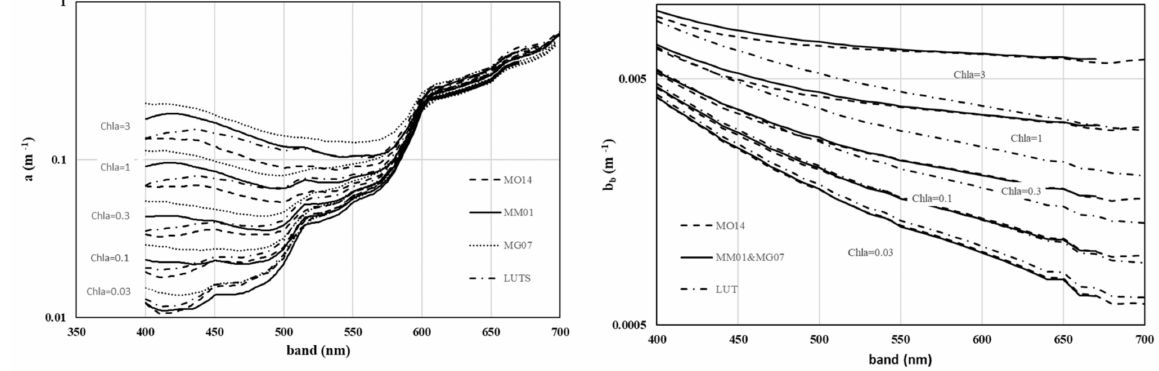
Figure 4. Difference in a ( λ ) and b b ( λ ) of MM01, MG07, MO14, and LUT models, when the concentration of chlorophyll is 0.03, 0.1, 0.3, 1 and 3 mg m − 3 (left is a ( λ ) , right is b b ( λ ) ).